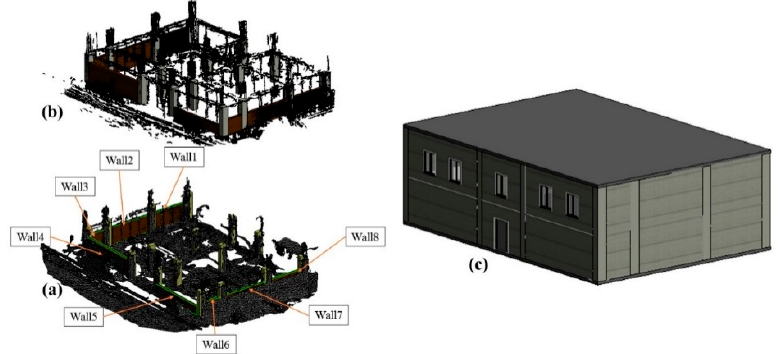
Figure 10. Case study 2: Generated as-built model vs as-planned model. ( a ) Generated as-built BIM by the proposed photogrammetric Multi-View Stereo method, ( b ) generated as-built BIM by the SFM/PMVS/CMVS algorithm, ( c ) as-planned BIM. Table 3. The quantities of performed work determined by the proposed photogrammetric Multi ‐ View Stereo method and SFM/CMVS/PMVS algorithm (case study 1). The building monitoring results Component Name